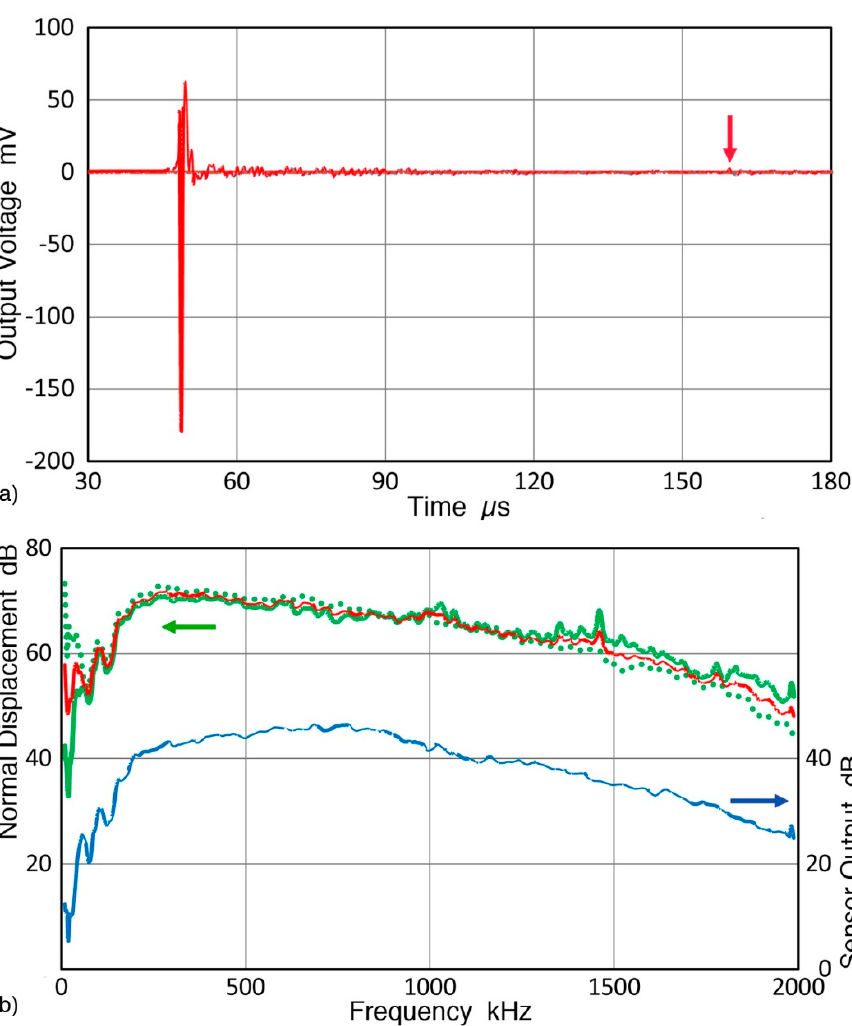
Figure 10. ( a ) RW pulses from angle beam ultrasonic transducer source received with a reference sensor, KRNBB-PCP. ( b ) The averaged spectrum of six received RW pulses (lower blue curve with right scale; 0 dB at 1 V). Also shown are the normal displacement spectrum of the RW pulses at the sensor position, (left scale; 0 dB at 1 nm). Green curve for KRNBB-PCP with waveform in Figure 10a, and green dot curve for KRNBB-PC. The averaged displacement spectrum is shown as red curve.